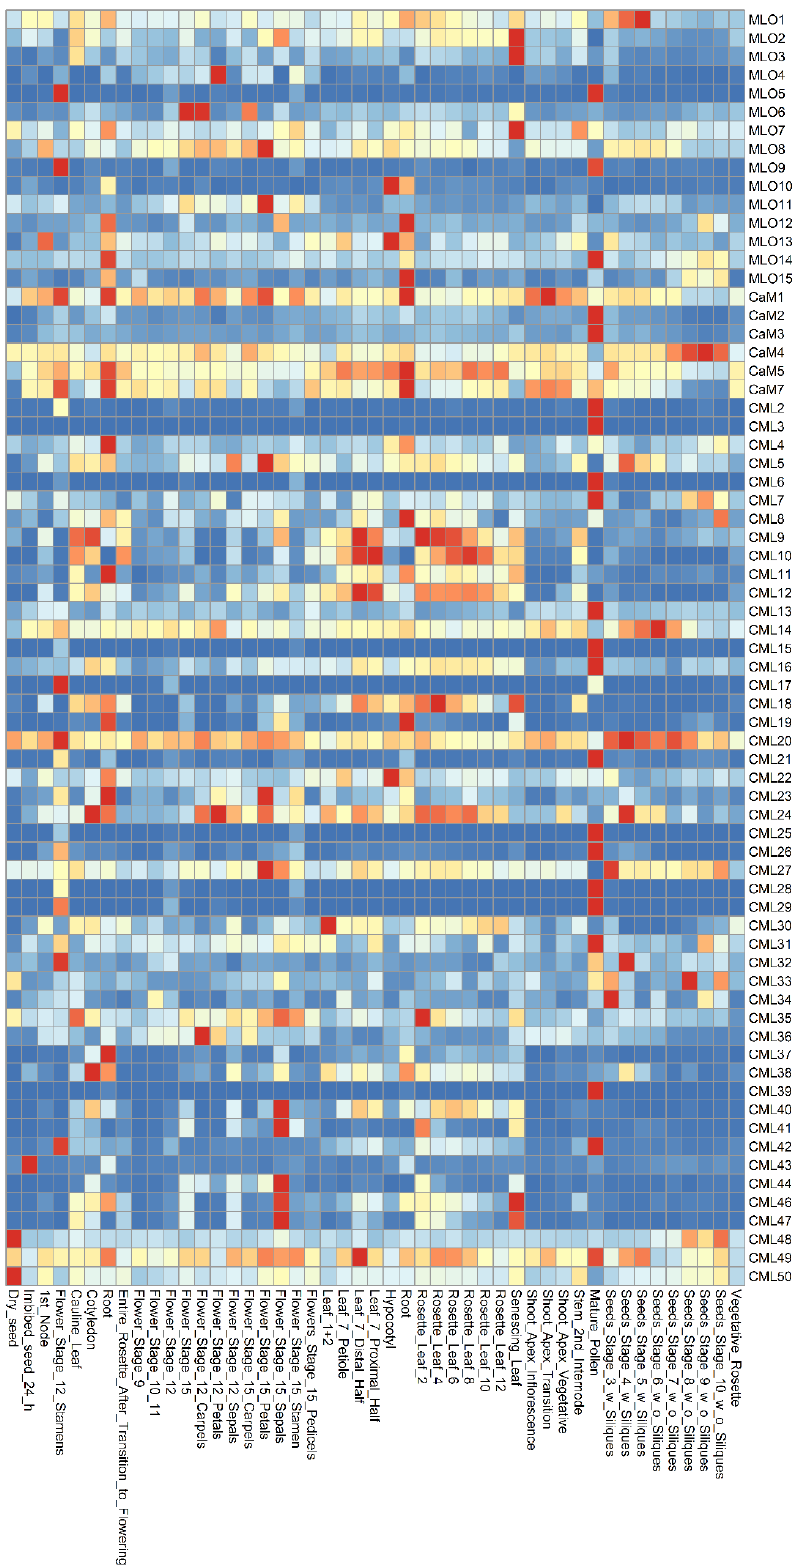
Figure 1. Expression pattern of Arabidopsis MLO and CaM/CML family genes.